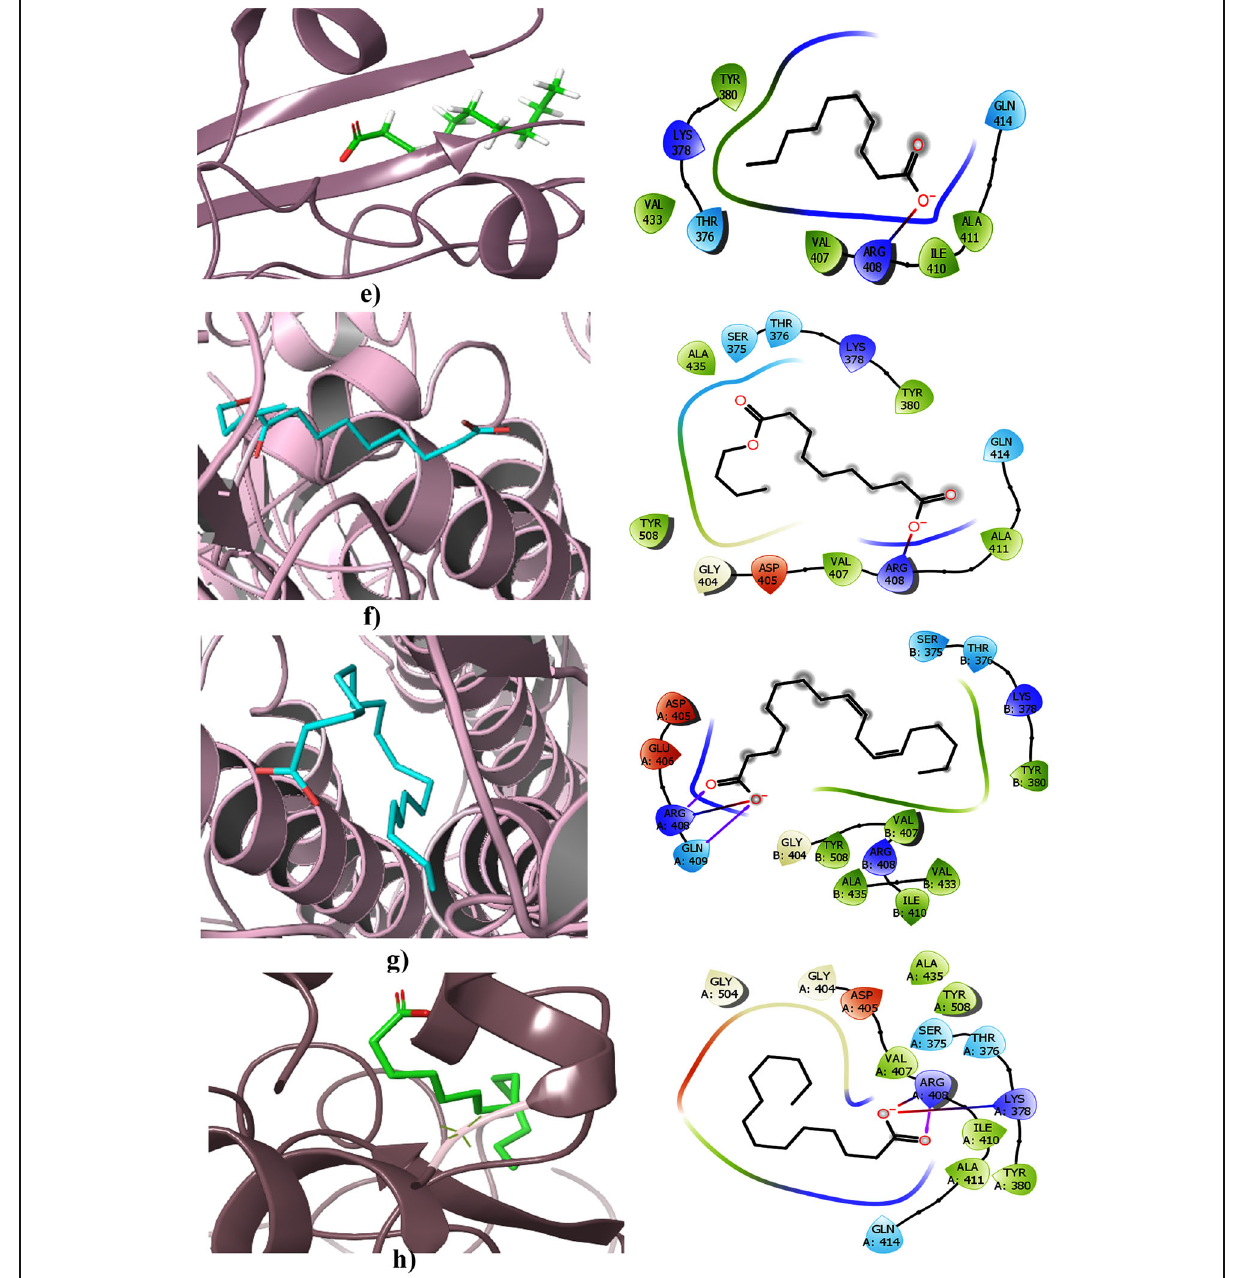
Fig. 7 Free fatty acids bound at the binding pocket in the RBD domain of spike proteins e capric acid; f caprylic acid; g linoleic acid; h myristic